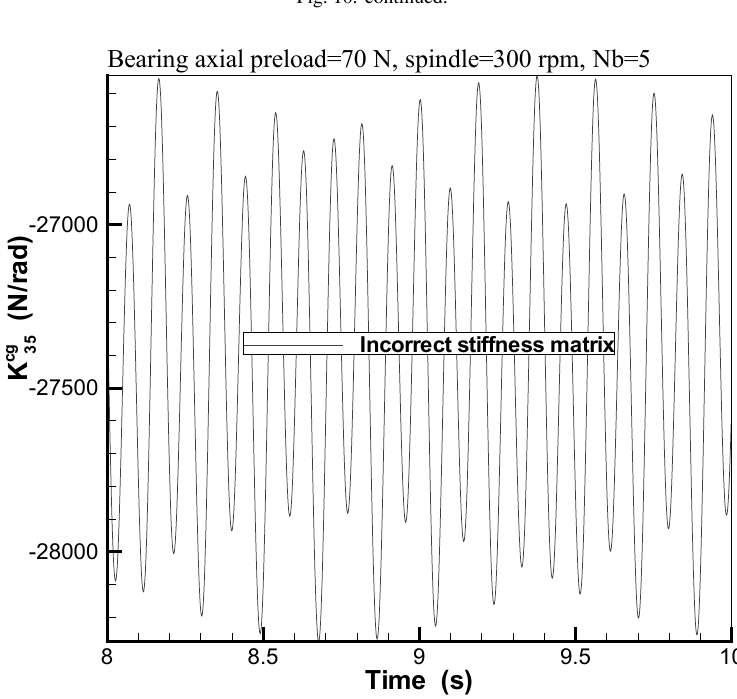
). Same input data as in Fig. 10(e) for the inc